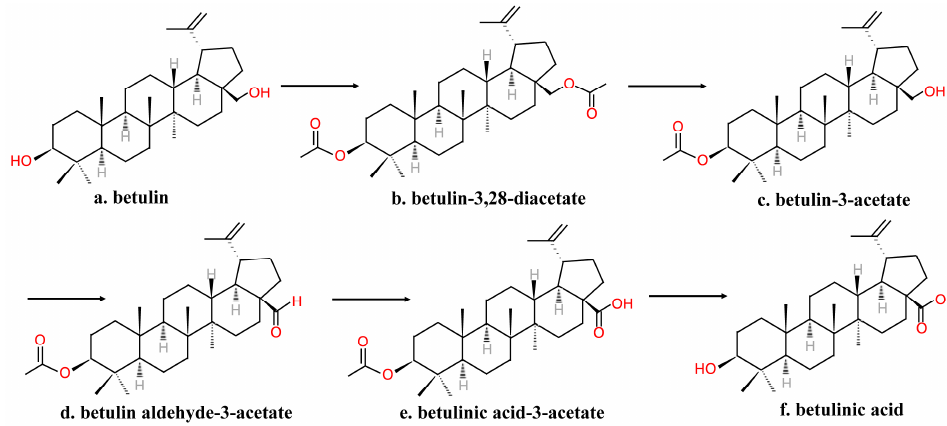
Figure 3. Krasutsky’s multistep method of manufacturing betulinic acid.